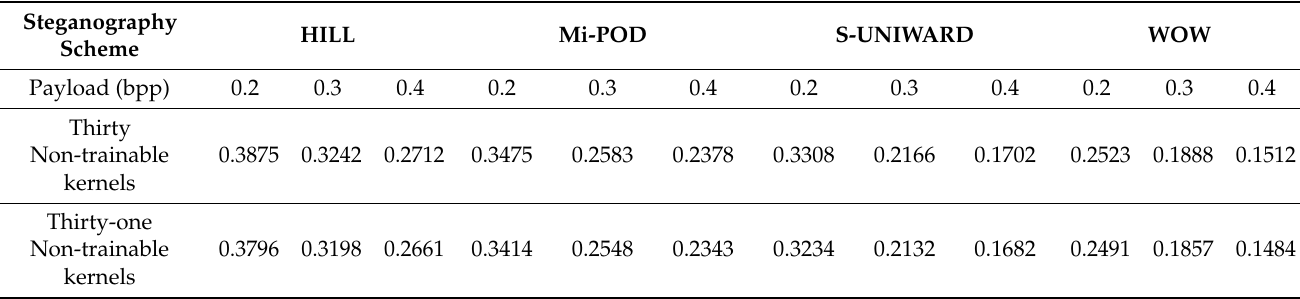
Table 1. Detection errors using thirty and thirty-one kernels.